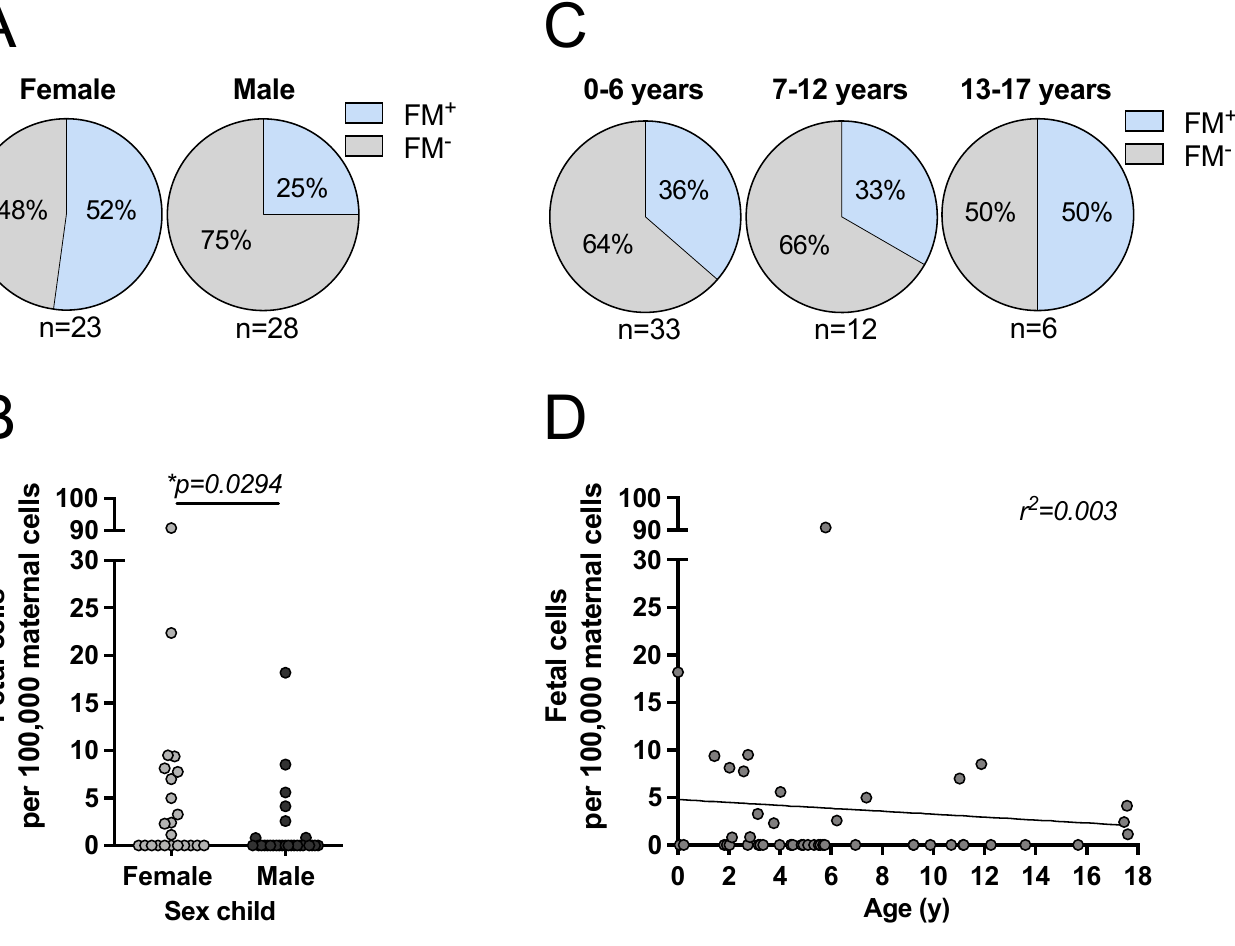
Figure 1. Correlation of child’s sex and age on the occurrence with the level of FM cells. FM was determined in mothers using ddPCR. The frequency of microchimeric cells was compared between mothers grouped depending on their children’s ( A ) sex, ( C ) age, and the level of FM was compared within the groups ( B , D ). Statistical analyses were performed using ( A ) Fisher’s exact test, ( B ) Mann– Whitney test, ( C ) Chi 2 test and ( D ) a simple linear regression analysis. Significance level * p <